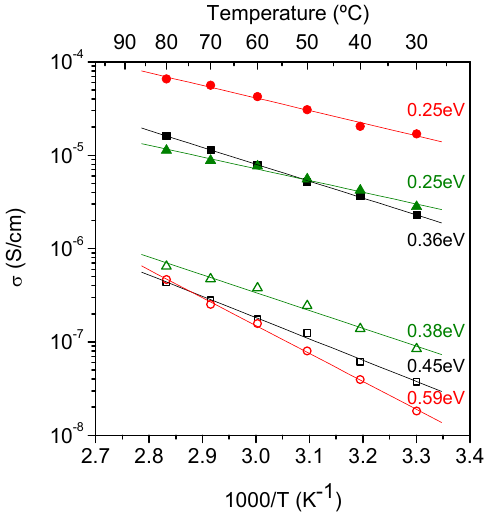
Figure 7. Arrhenius plots in the range between 30 and 80 °C at 75% (empty) and 95% RH (filled) for Compounds 1 (black), 1deh (red), and 2 (green).